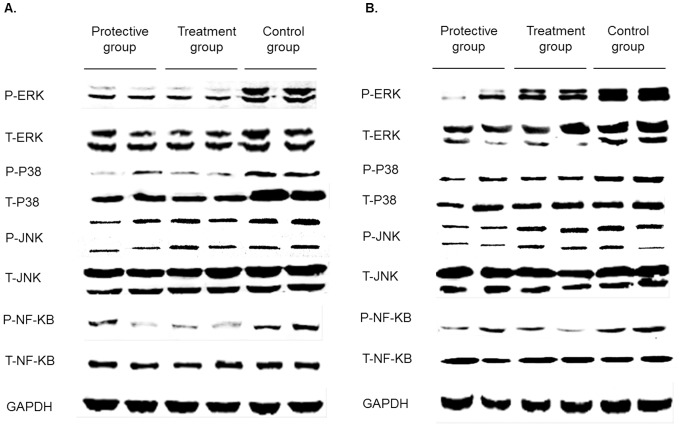
The expression of MAPK and NF-κB proteins in vivo.MAPK and NF-κB proteins expression were down-regulated in the xenograft tumors of 5-8F(A) and CNE2(B) in I3C preventive and I3C treatment groups compared to the control group. The data are presented as the mean± SEM.